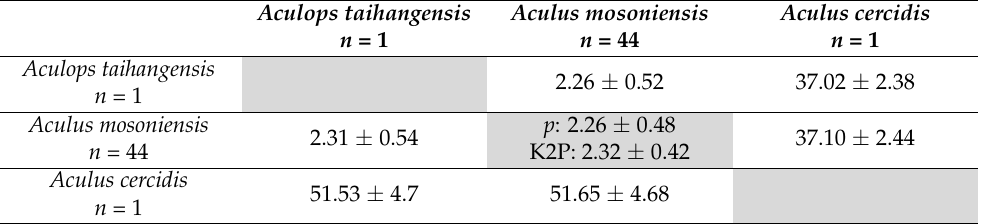
Table 3. ITS1 pairwise distance matrix with uncorrected p distances shown as percentages (above the diagonal) and K2P distances (under the diagonal) within Aculus mosoniensis ; between Aculus mosoniensis , Aculops taihangensis, and one congener ( Aculus cercidis ); and within Aculus mosoniensis (in the diagonal). Data are expressed as mean ±